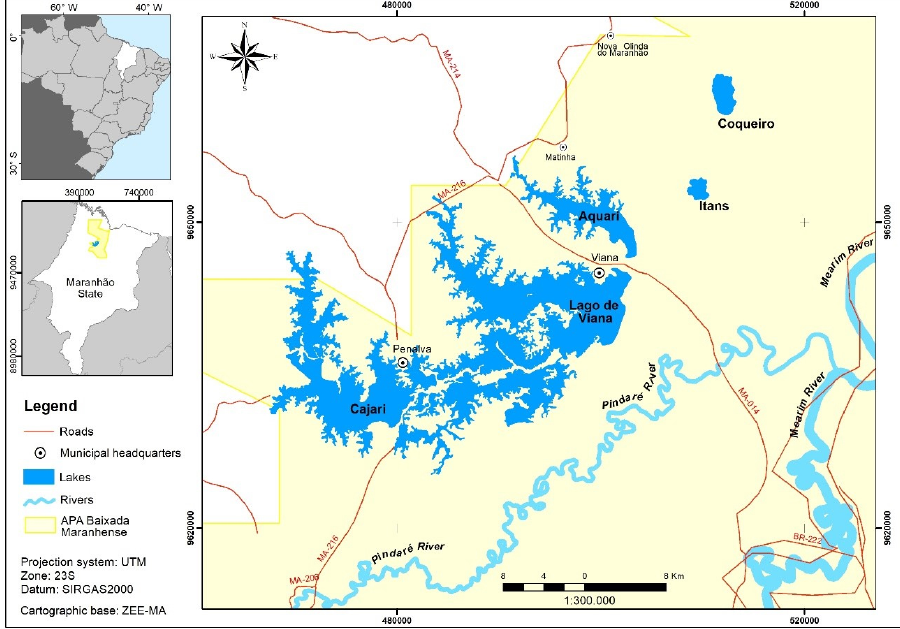
FIGURE 1 | Map of Baixada Maranhense Environmental Protection Area, a Brazilian Ramsar